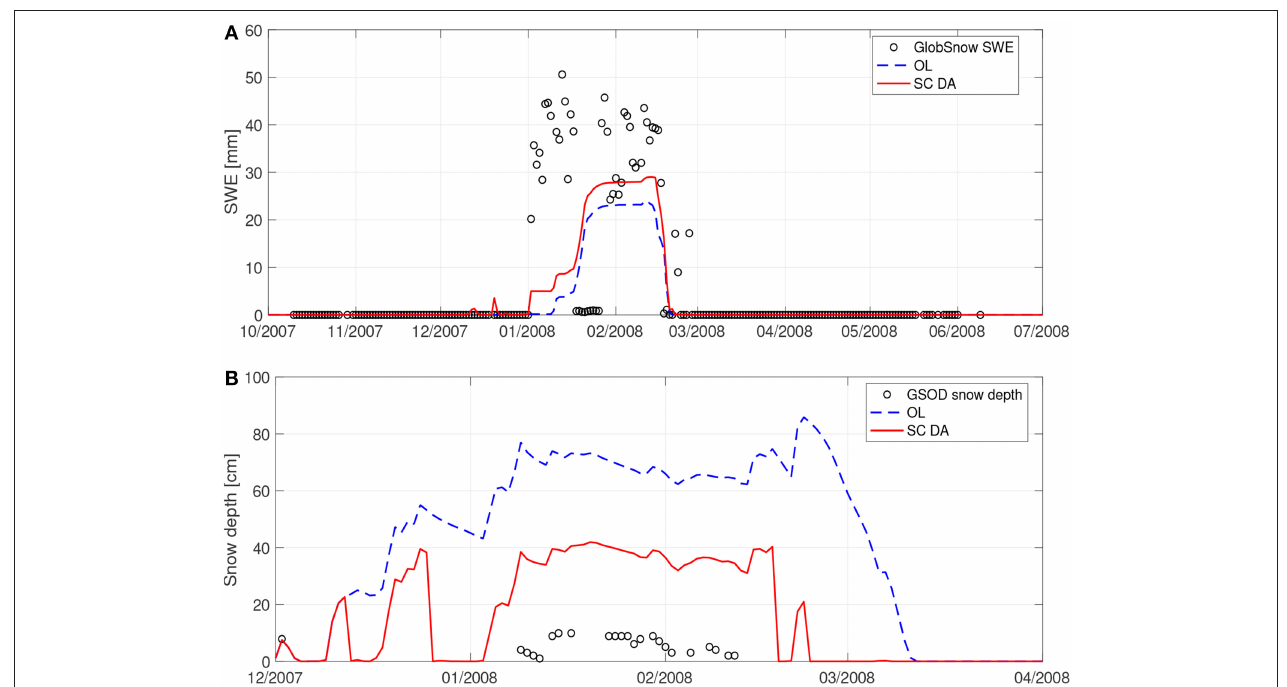
FIGURE 2 | (A) Comparison of OL and SC DA derived SWE against GlobSnow SWE estimates at (39.48 ◦ N, 76.00 ◦ E) between 01 October 2007 and 01 July 2008 (with white gaps representing missing GlobSnow estimates). Time series between September and October, and between July and August are not shown in the Figure because no GlobSnow estimates are available. (B) Comparison of OL and SC DA derived snow depth against GSOD snow depth measurements at (38.55 ◦ N, 68.83 ◦ E) between 1 December 2007 and 1 April 2008 (with white gaps representing missing GSOD measurements). Time series between September and December, and between April and August are not shown in the Figure because no GSOD measurements are available.